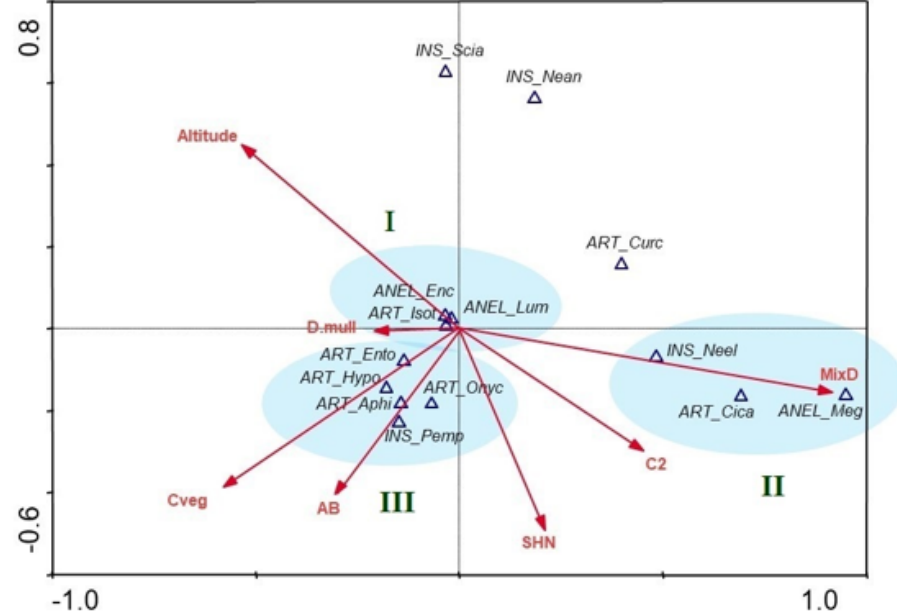
Figure 4. Biplot of forests environmental features and soil communities resulting from CCA analysis (environmental features are indicated in red, soil communities are indicated in black with a blue triangle, and blue circles with Roman numeral indicate clusters). The suffixes ART, ANEL, and INS refer to the targets—Arthropods, annelids, and insects.